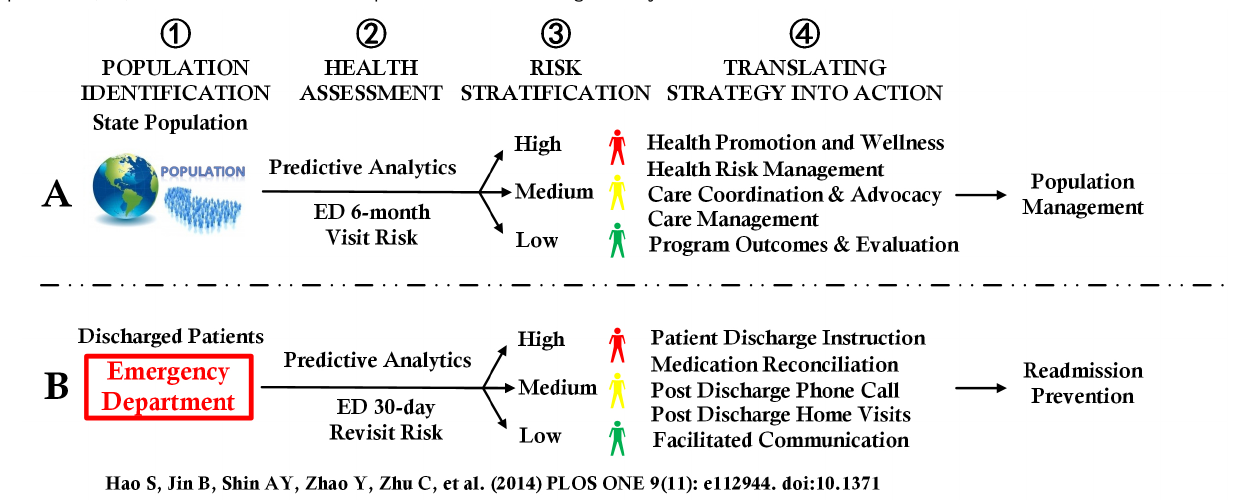
Figure 1. Integrating predictive analytics into workflows of proactive population health management and hospital quality improvement;